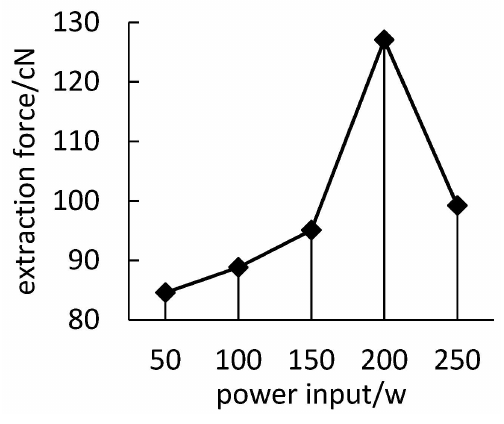
Figure 5. Effect of input